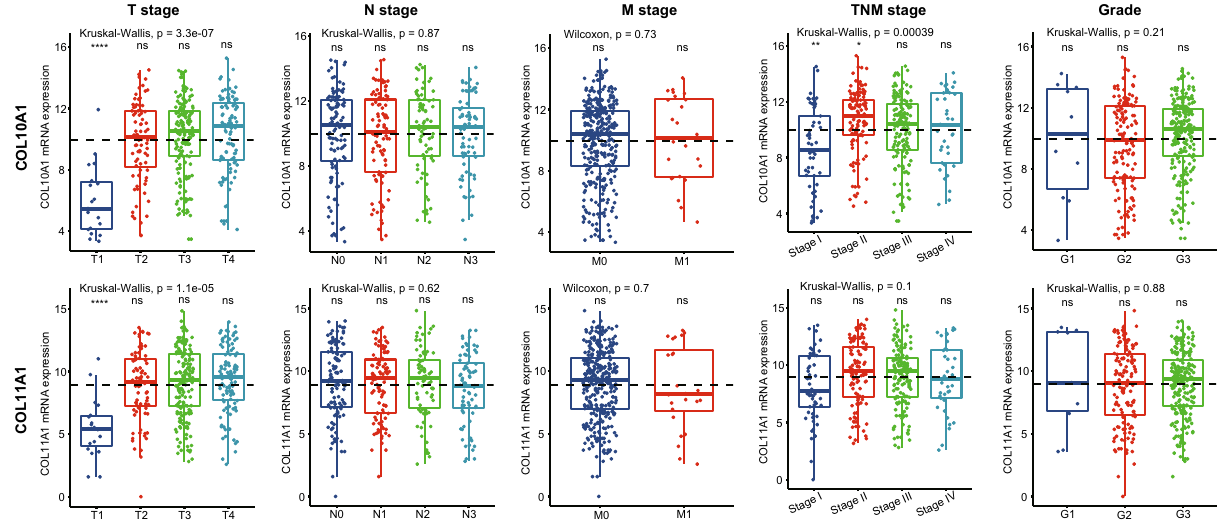
Figure 2. Differential expression of COL10A1 and COL11A1 between different stages of GC. The mean mRNA expression value of each gene in all tumor samples was set as reference for all the comparisons.